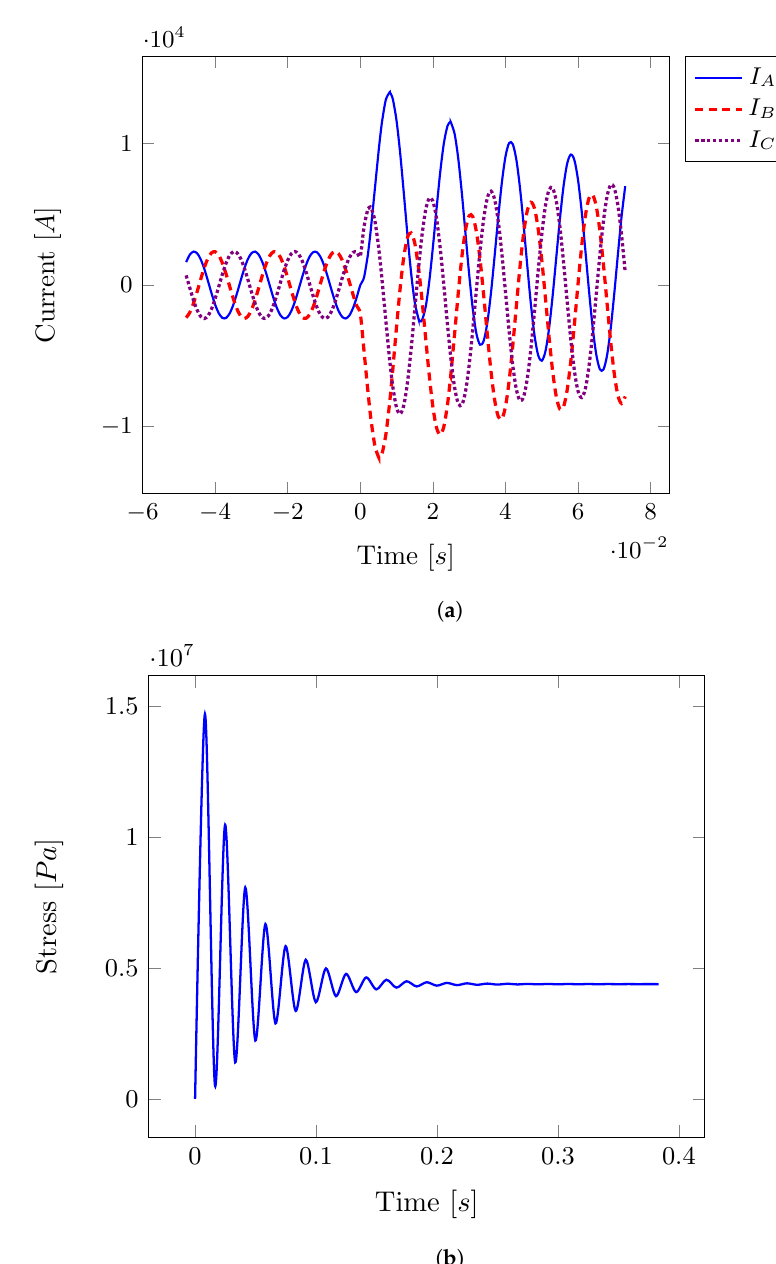
Figure 7. Current and stress for a three-phase fault with a system equivalent impedance R = 1 and X L = 15. ( a ) Current on the three phases; ( b ) Stress on phase